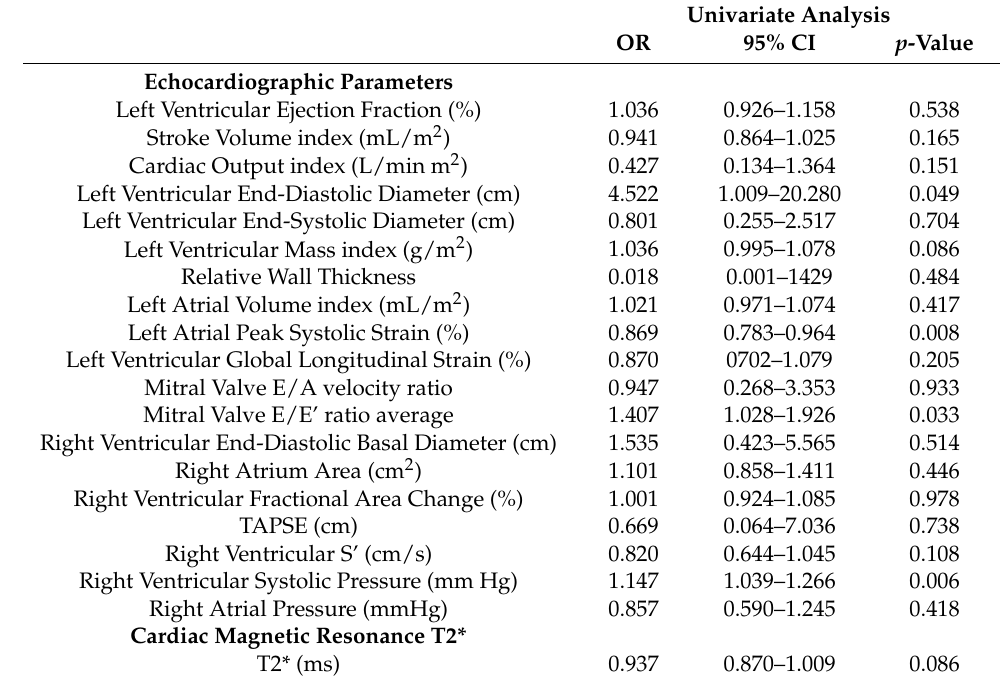
Table 5. Cardiac imaging univariate associates of premature atrial contractions > 24/day in β -thalassemia-major